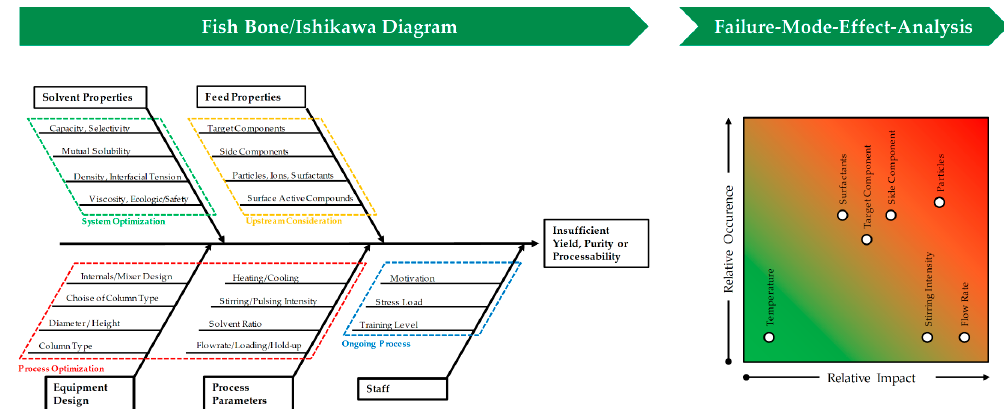
Figure 2. Construction of Ishikawa diagram and corresponding FMEA (failure-mode-effect- analysis) visualization are key-steps in risk assessment in a Quality-by-Design based process development.